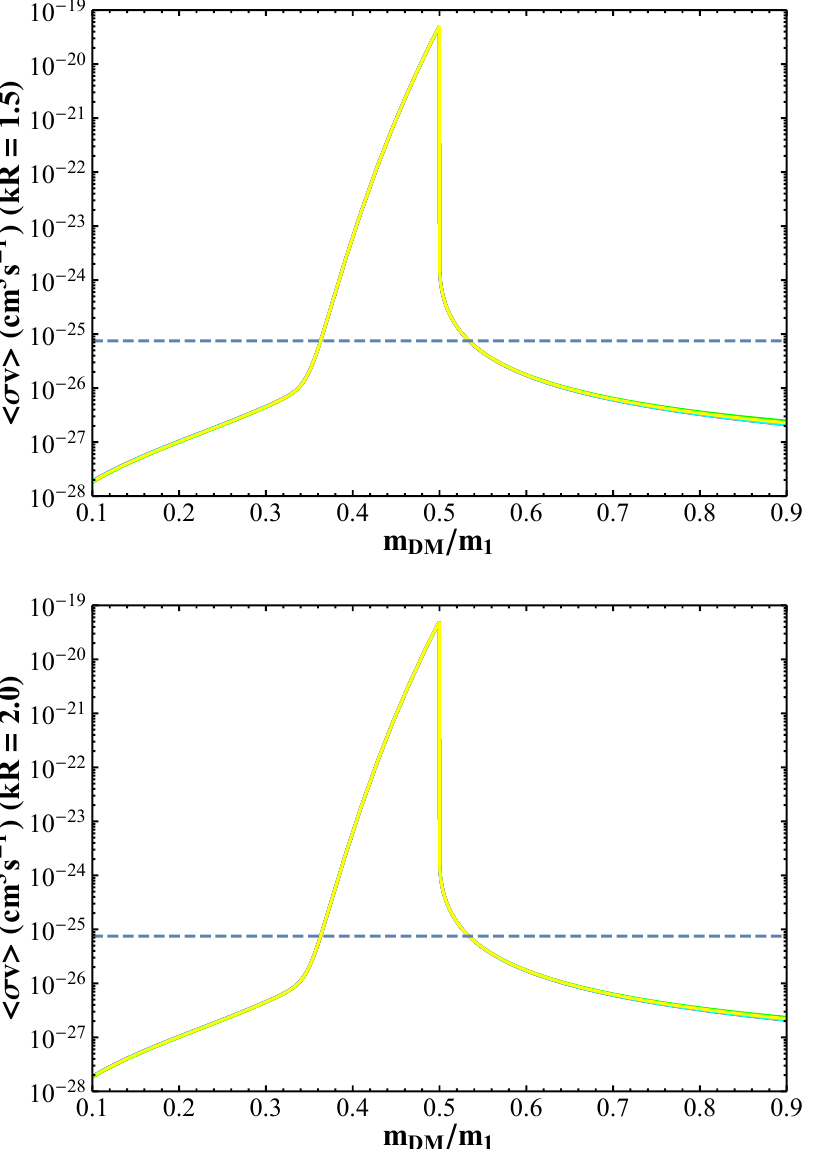
Figure 19 . (Top) The thermally averaged annihilation cross section in cm 3 / s, assuming kR = 1 . 5 for various choices of (( kR ) τ, a W ) =(1/2,1/2) [red], (1/2,1) [blue], (1/2,3/2) [green], (1,1/2) [magenta], (3/2,1/2) [cyan] and (1,1) [yellow], respectively. (Bottom) As in the previous panel, but assuming kR = 2 . 0